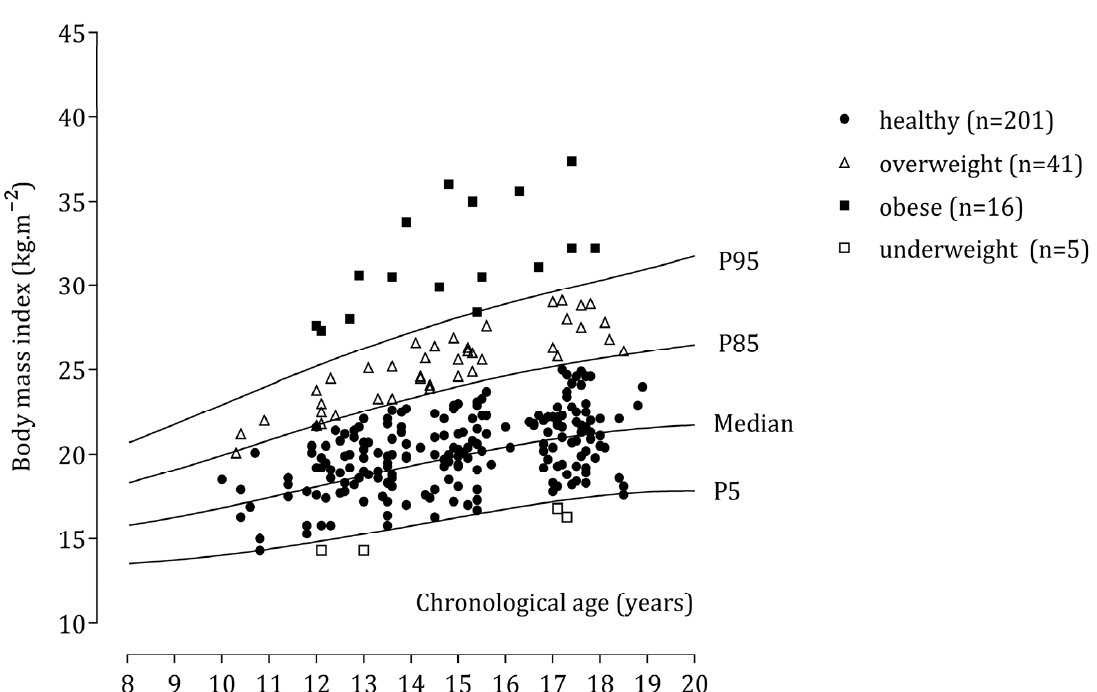
Figure 2. Body mass index of individual female school participants plotted relative to U.S. data.